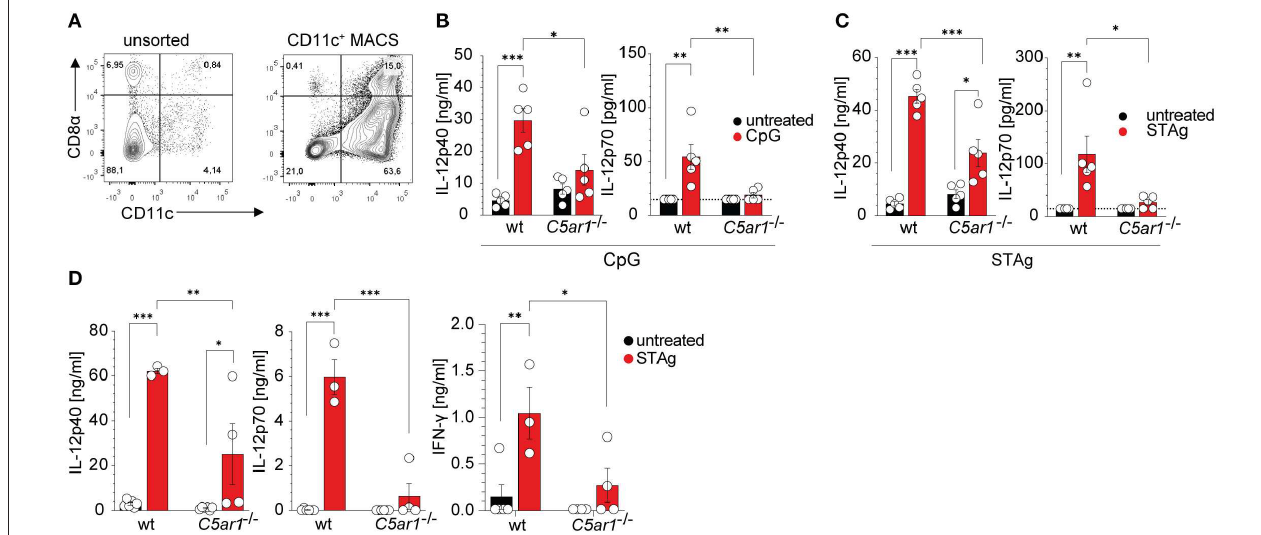
FIGURE 7 | The C5a/C5aR1 axis controls TLR9 and STAg-induced IL-12 production from spleen-residing DCs. (A) Dot plots showing the frequencies of unsorted (left) and CD11c + MACS positively selected (right) splenic DCs. The numbers in the four quadrants show the frequencies of the individual cell populations. (B) Impact of CpG ODN1668 (1 µ g/ml) or (C) STAg (1 µ g/ml) stimulation of splenic DCs (1 × 10 6 ) from wt or C5ar1 − / − mice on IL-12p40 (left) and IL-12p70 (right) production. The dotted line depicts the detection limit of the assay, n = 5/group. (D) Impact of STAg injection (i. p., 100 µ g, 6h) on IL-12p40 (left), IL-12p70 (middle), and IFN- γ (right) serum concentrations in wt and C5ar1 − / − mice. The dotted line depicts the detection limit of the assay, n = 3–6/group. Values shown in (B–D) are the mean ± SEM, differences between groups were determined by ANOVA and Sidak’s post-hoc test, * p < 0.05, ** p < 0.01, *** p <